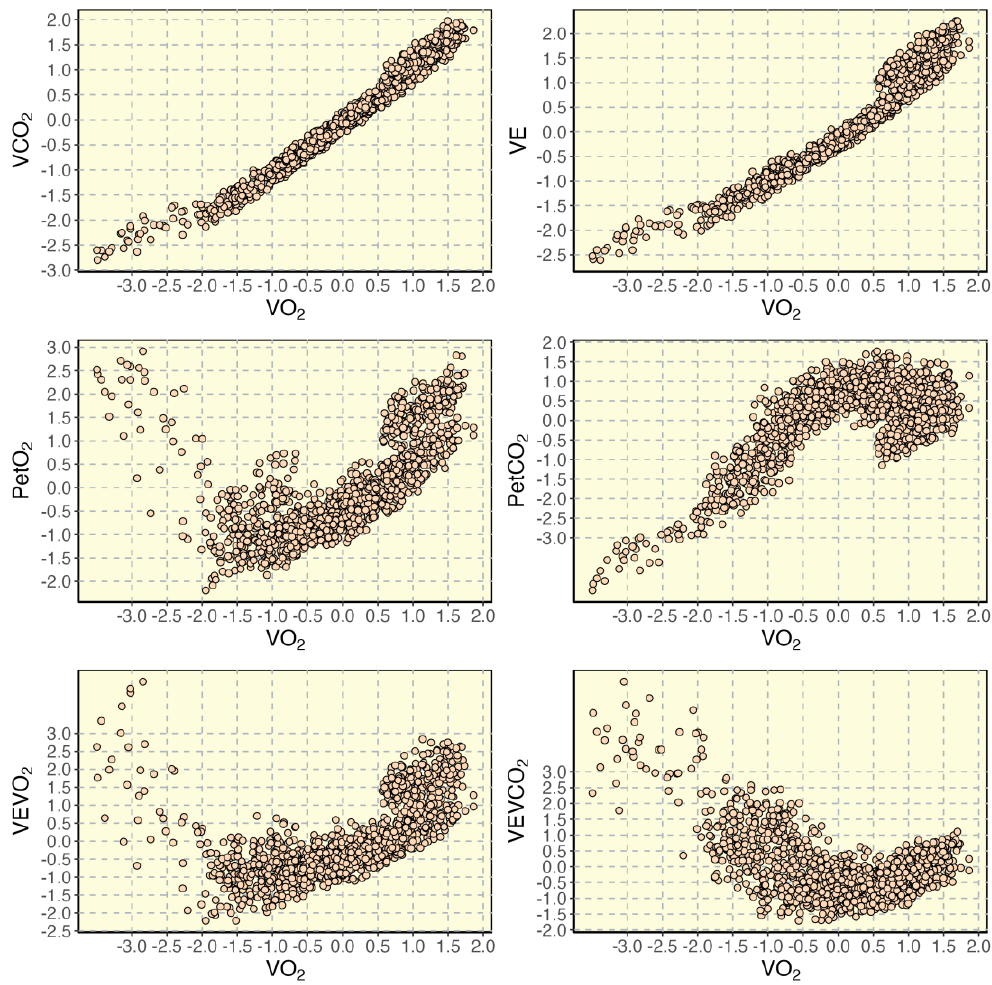
Figure 1. Main ventilatory variables collected during a CPET (standardized units) for a representative individual: exhaled CO 2 (VCO 2 ), ventilation (VE), end-tidal O 2 (PetO 2 ) and CO 2 (PetCO 2 ), ventilatory equivalents (i.e., VEVO 2 and VEVCO 2 ) are plotted relative to O 2 uptake (VO 2 ).